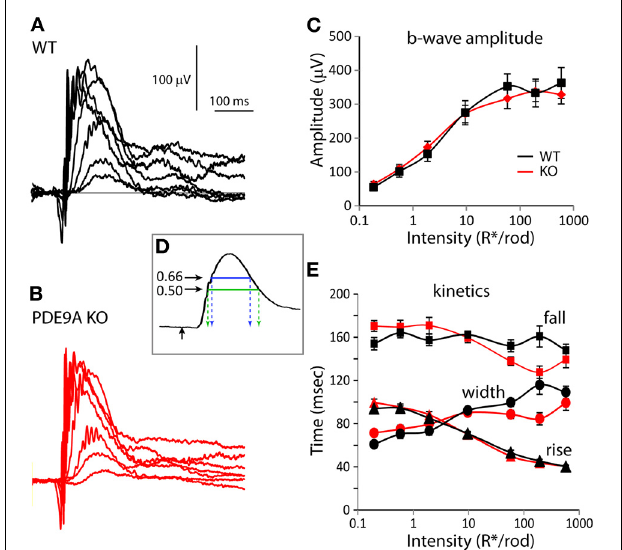
FIGURE 1 | PDE9A does not contribute to the ERG under scotopic conditions. For all figures, WT is drawn in black and KO in red. Also for all figures, data are plotted as average ± s.e.m. When the s.e.m. cannot be seen, it is smaller than the symbol. (A,B) Representative responses to increasing light intensities (0.2– 600 R ∗ /rod) from age matched WT (A) and PDE9A KO (B) retinas. (C) Average b-wave amplitudes vs. flash intensity for WT (black squares; 16–22 records) and KO (red diamonds; 18–28 records) mice. (D) Illustration of the parameters used to characterize the kinetics of the b-wave. Stimulus onset is designated by an upward black arrow, 66% of the peak amplitude is indicated by the blue line and 50% by the green line. Time taken by the b-wave to rise from the stimulus onset to 66% of its peak amplitude (left dashed blue arrow) or to 50% of its amplitude (left dashed green arrow) were used for comparison of its kinetics. Time taken by the b-wave to fall to 66 or 50% of its peak amplitude is indicated by the right blue and green arrows. (E) Times taken by the b-wave to rise (triangles) and fall (squares) to 66% of its amplitude, and the duration between them (width, circles) at the measured